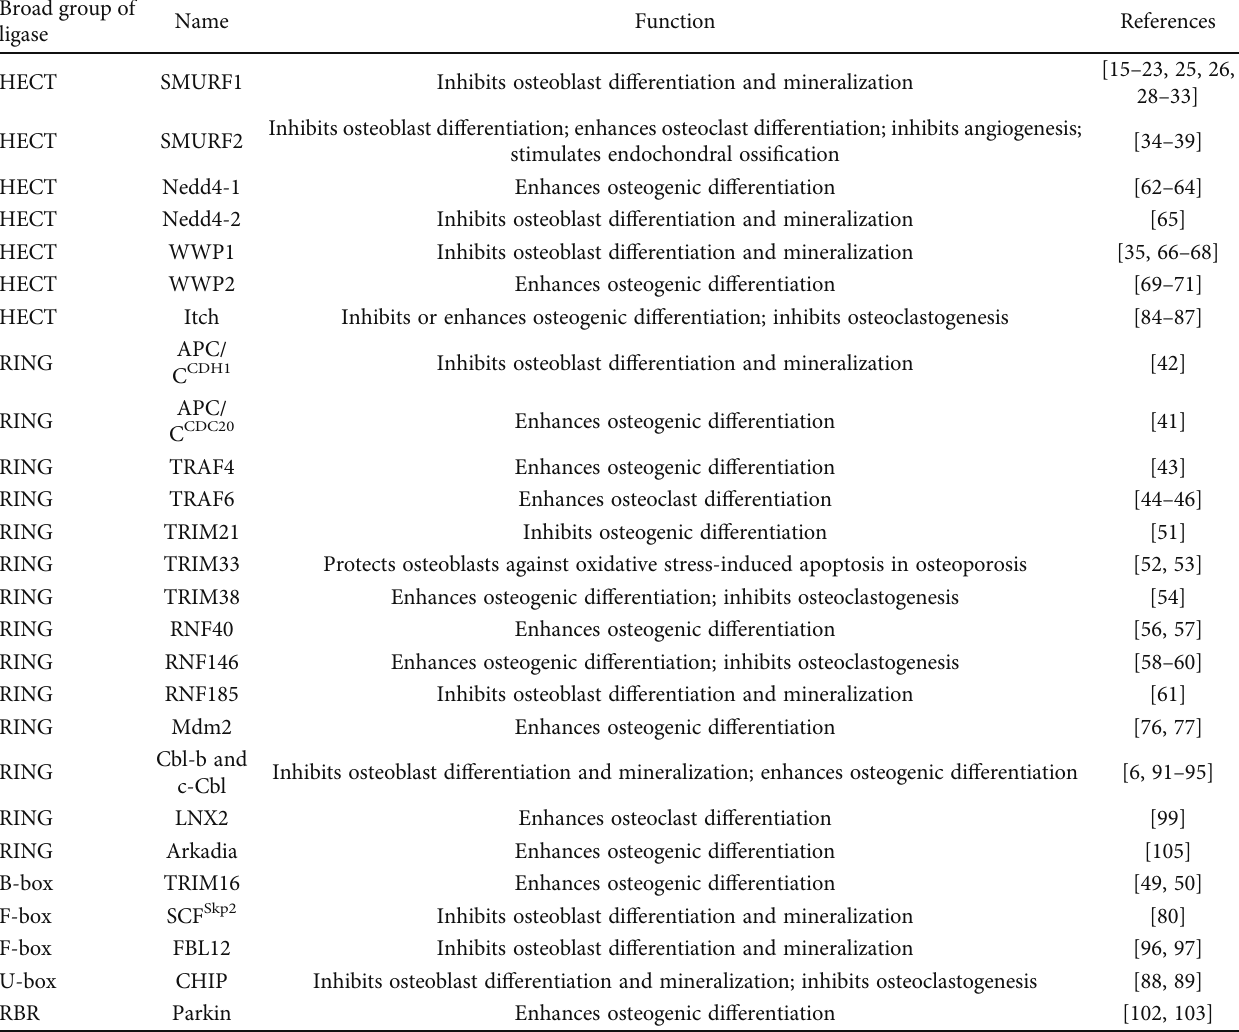
Table 1: E3 ubiquitin ligases and bone